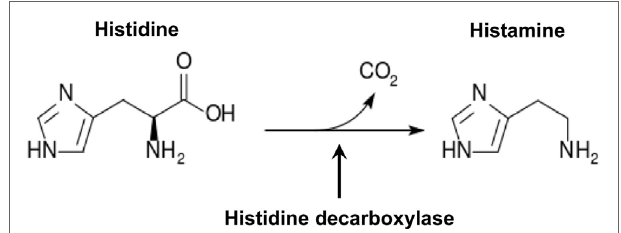
FigURe 1 | Histamine